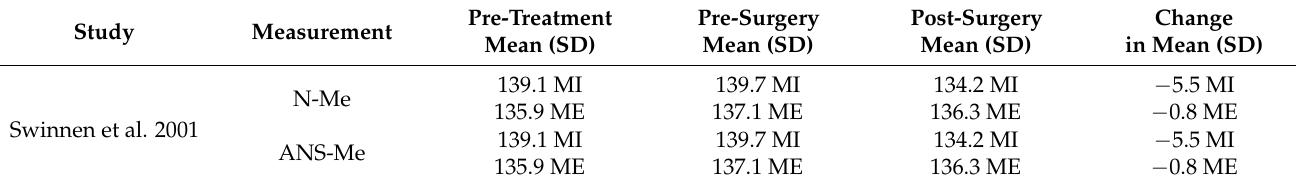
Table 11. The change in the facial height as a result of orthognathic surgery (mm). Study